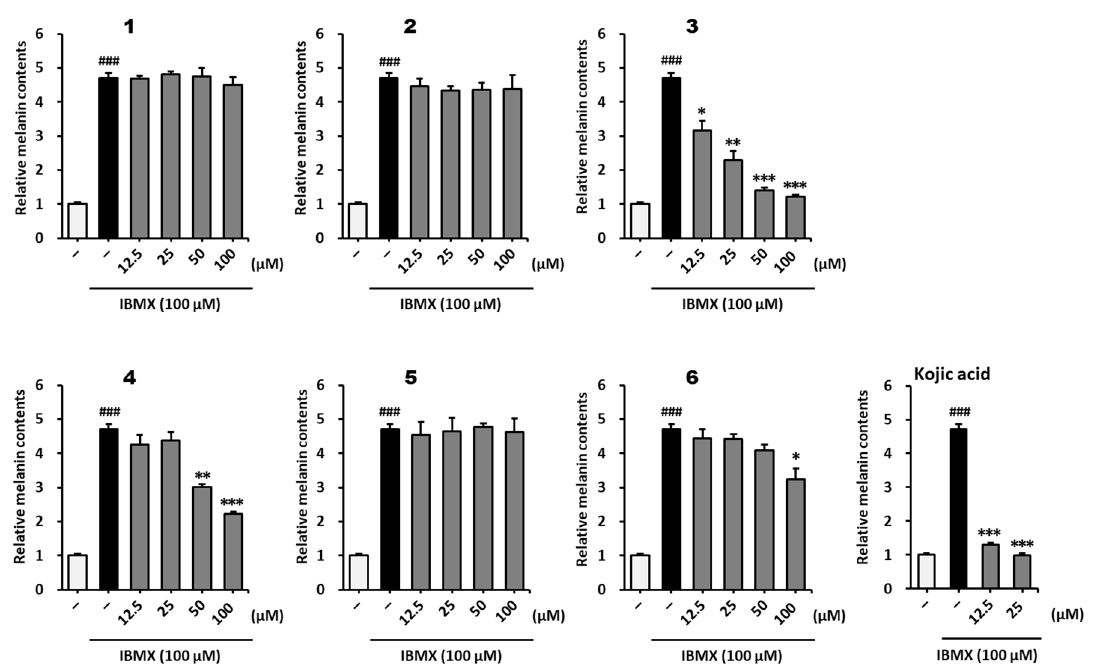
Figure 5. Effect of methoxyflavones 1 – 6 on melanogenesis in B16F10 cells. B16F10 cells were seeded in a 60 mm dish at a density of 5 × 10 5 cells and incubated for 24 h. The cells were then incubated with IBMX and the indicated concentrations of methoxyflavones 1 – 6 for 72 h. Melanin content was evaluated using 1 N sodium hydroxide. Kojic acid was used as a positive control. The results are presented as the mean ± SEM ( n =3). ### p < 0.001 compared to the untreated group. * p < 0.05, ** p < 0.01, and *** p < 0.001 compared to the IBMX-treated group.